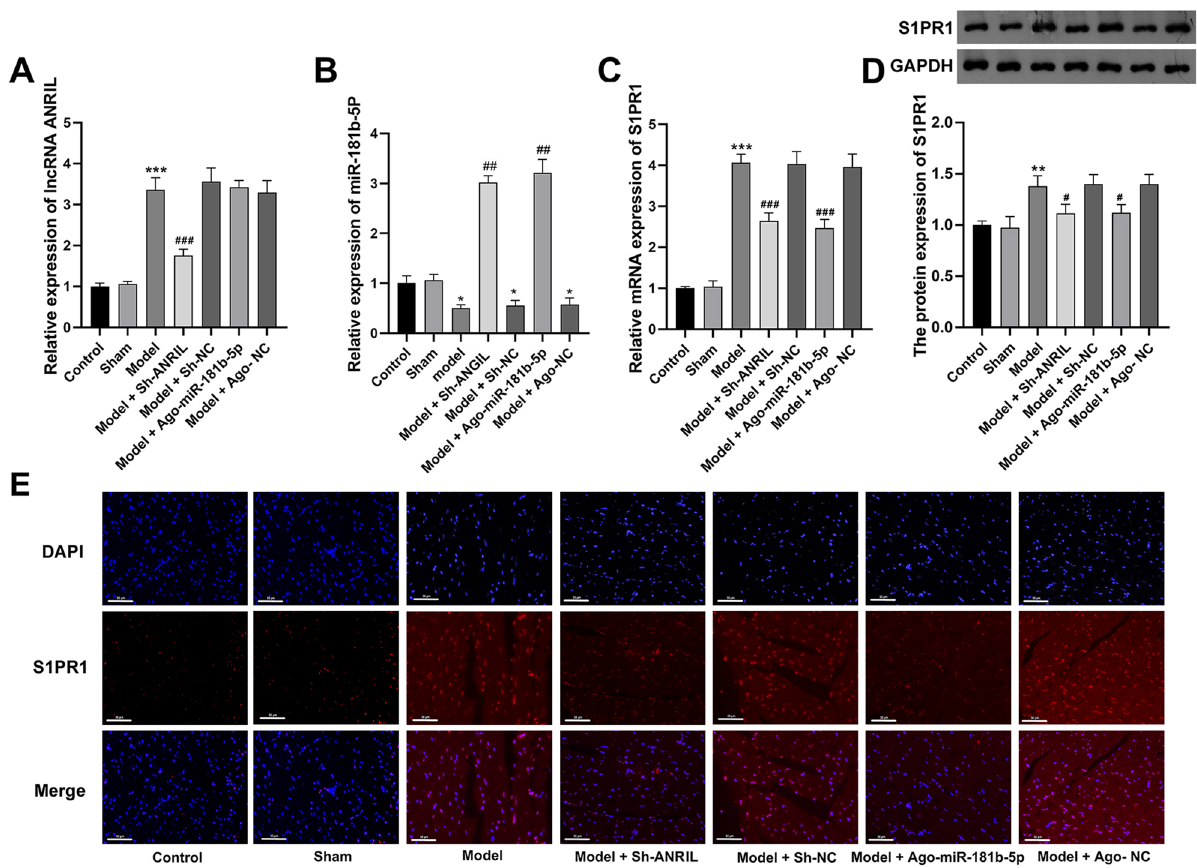
Figure 4. The intervention of ANRIL/miR-181b-5p/S1PR1 expression in UC mice ( A ) qRT-PCR of ANRIL expression; ( B ) qRT-PCR of miR-181b-5p expression; ( C ) qRT-PCR of S1PR1 mRNA expression; ( D ) Western blot of S1PR1 protein expression; ( E ) immunofluorescence of S1PR1 expression, scale bar = 50 μm. **P < 0.01, ***P < 0.001 vs. control; # P < 0.05, ### P < 0.001 vs. model. Data was analyzed using t test or one-way analysis of variance (ANOVA) followed by Tukey’s